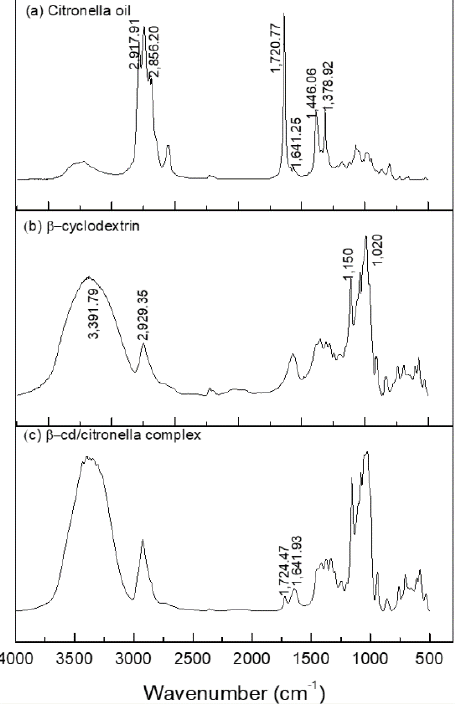
Figure 4. Spectroscopy in the infrared region of: ( a ) citronella oil, ( b ) βCD, ( c ) βCD–citronella oil complex.